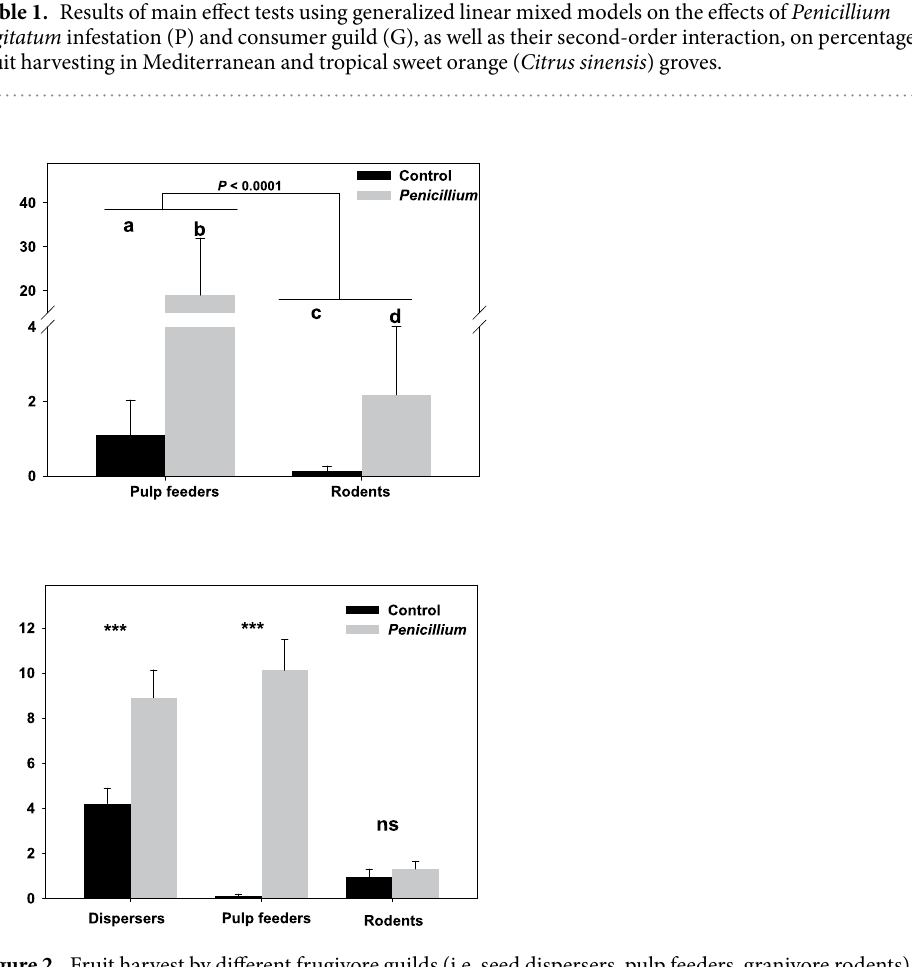
Figure 2. Fruit harvest by different frugivore guilds (i.e. seed dispersers, pulp feeders, granivore rodents). Model corrected mean percentages ( ± 1SE) of sweet orange ( Citrus sinensis ) fruit harvest by different frugivore guilds as a function of Penicillium infestation in the Mediterranean ( A ) and tropical groves ( B ). Different lowercase letters among Penicillium infestation levels denote significant ( P < 0.05) differences. *** P < 0.0001; ns, not significant ( P >